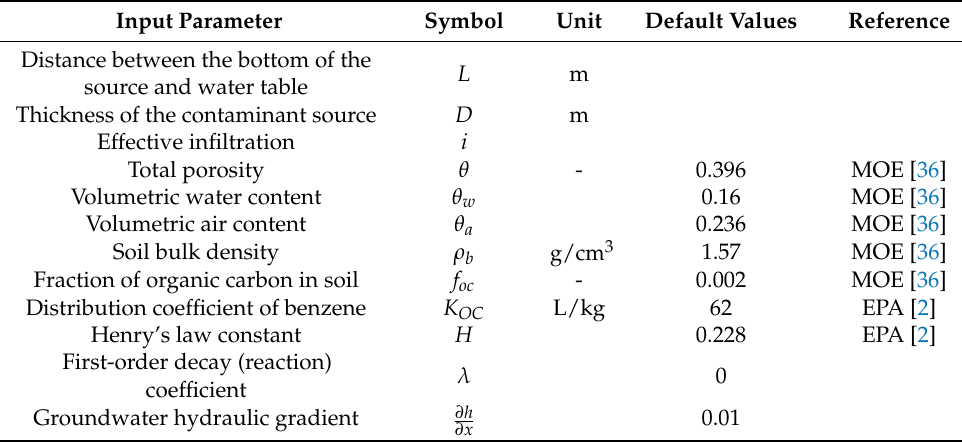
Table 1. Summary of the model input parameters and default